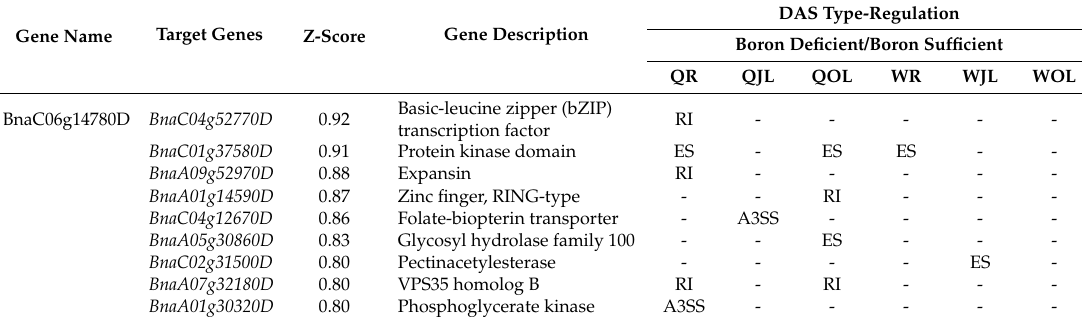
Table 6. Different types of target genes and gene interaction in the splicing factor gene network of B. napus cultivars Qingyou10 and Westar10 under boron deficient